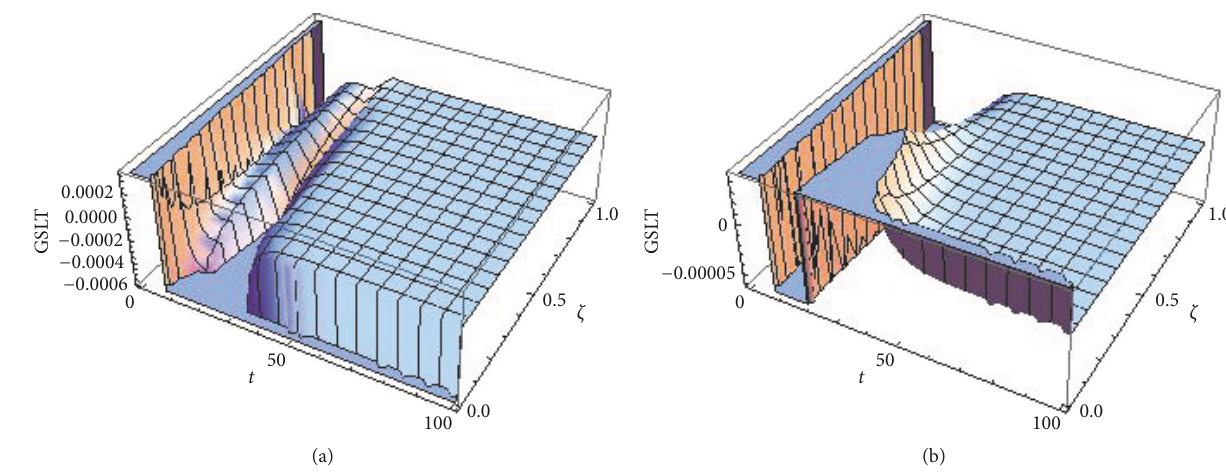
Figure 7: Validity of GSLT for the model (52). (a) is for 𝑑 1 = 𝑑 3 = 1 and (b) for 𝑑 1 = 1 and 𝑑 3 = −1